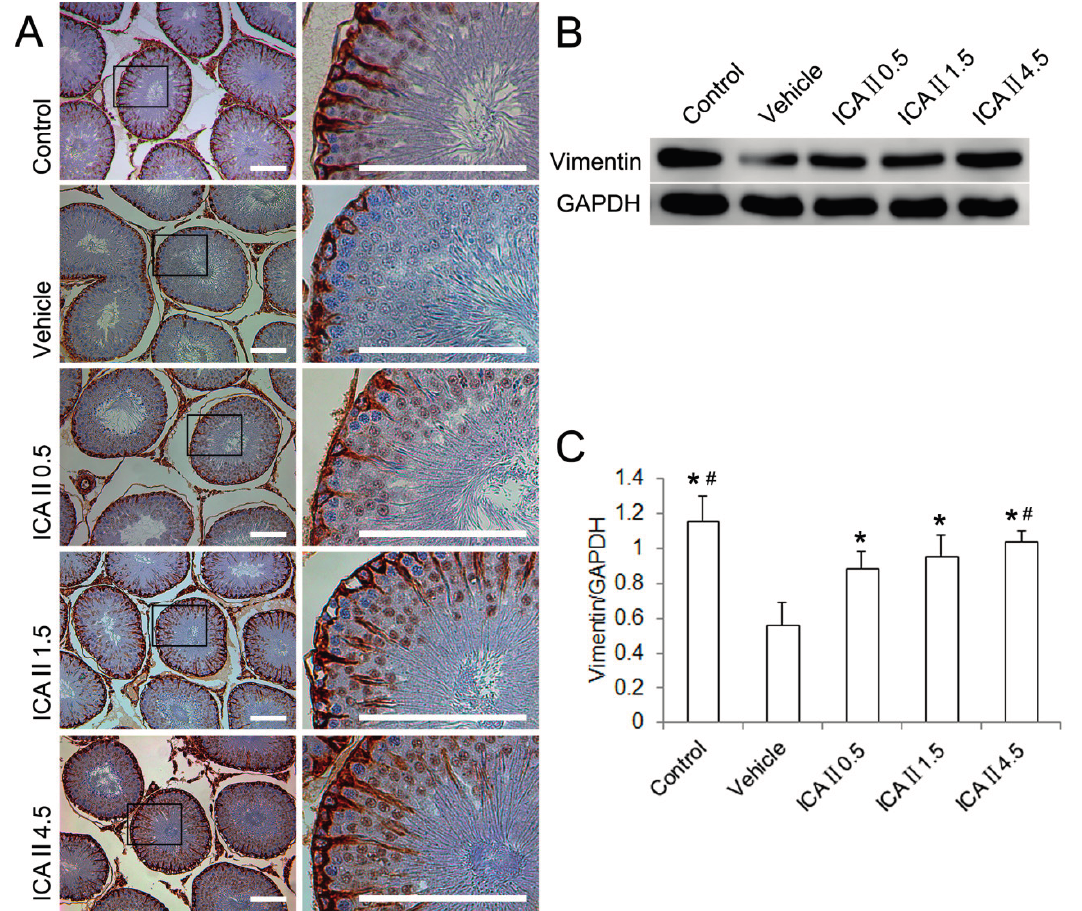
Figure 3. The changes of Sertoli cell Vimentin filaments. ( A ) Distribution and appearance of Sertoli cell Vimentin filaments (immunohistochemical staining). The Vimentin filaments in the control group have a characteristic “spoke-like” appearance; in the vehicle group, the Vimentin filaments lose their apical extensions and mainly concentrate surrounding the nucleus; ICAII (0.5, 1.5 or 4.5 mg/kg/day, respectively) treatments preserve the apical extensions of the Vimentin filaments in a dose-dependent manner. Boxed areas in the 100× graphs are shown in the corresponding graphs on the right panels; ( B ) The protein expression of the Vimentin filaments (western blot); ( C ) Semi-quantitative analysis of Vimentin filaments protein expression in testes with WB. * p < 0.05 compared with the vehicle group; # p < 0.05 compared with the ICAII0.5 group. Scale bar = 100 μ